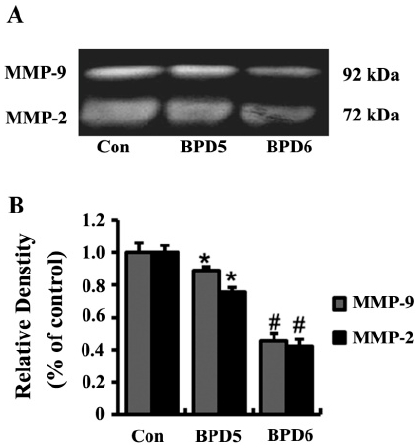
Figure 6. BPDs 5 and 6 inhibited MMP-2 and MMP-9 activity. MMP-2 and MMP-9 activities were determined by gelatin zymography. ( A ) The 72-kDa and 92-kDa correspond to MMP-2 and MMP-9, respectively; ( B ) MMP-2 and MMP-9 activities were quantified by densitometric analysis. Results are the mean ± SD from three independent preparations. *, p < 0.05 compared with control group. #, p < 0.01 compared with 5 treatment.